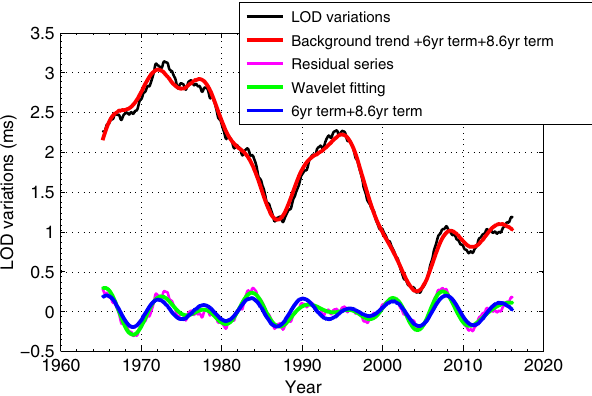
Fig. 3 Comparisons of the recovered results and the original LOD variations. In this fi gure, LOD data refers to the observed LOD data (from which the AAM effect has been removed, while a running average approach is managed to remove the remaining annual and semi-annual signals) as displayed in Fig. 1a; Background trend indicates the decadal variations presented in Fig. 1a. Residual series mainly re fl ects the intradecadal variations which is obtained from the Original data minus the Background trend.